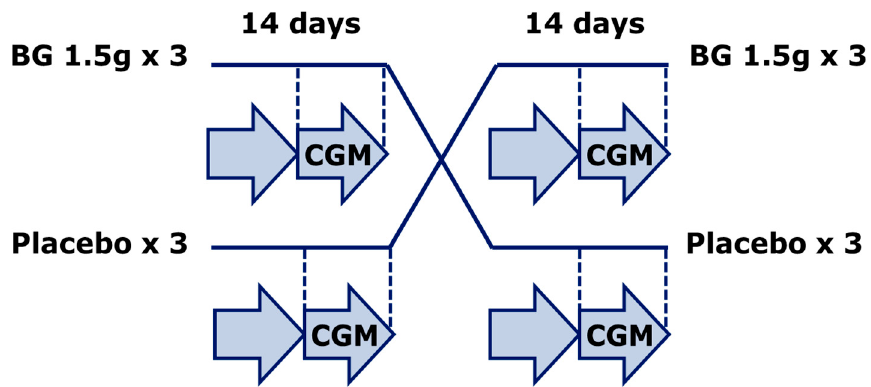
Figure 1. Study setup . A double blind placebo controlled crossover design with patients with type 1 diabetes (T1D) randomized to either betaglucan (BG) tablets (1.5 g before meals three times daily) or placebo for 14 days followed by a one-week wash-out period and a new 14-day treatment period. Plasma glucose variability was assessed by blinded continuous glucose monitoring (CGM) during the last 7 days of each treatment period.